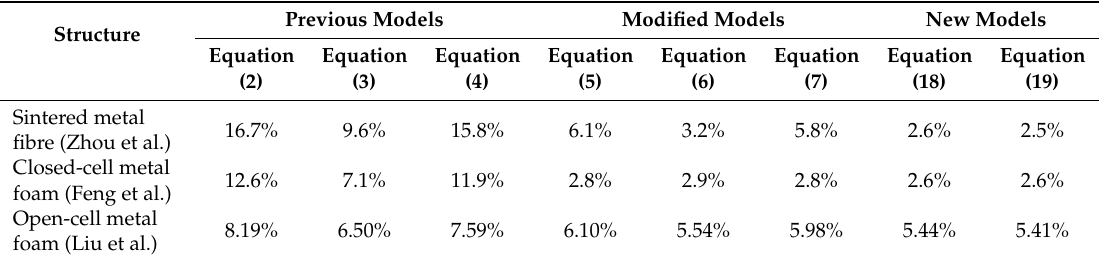
Table 5. Average absolute relative error from different models for different